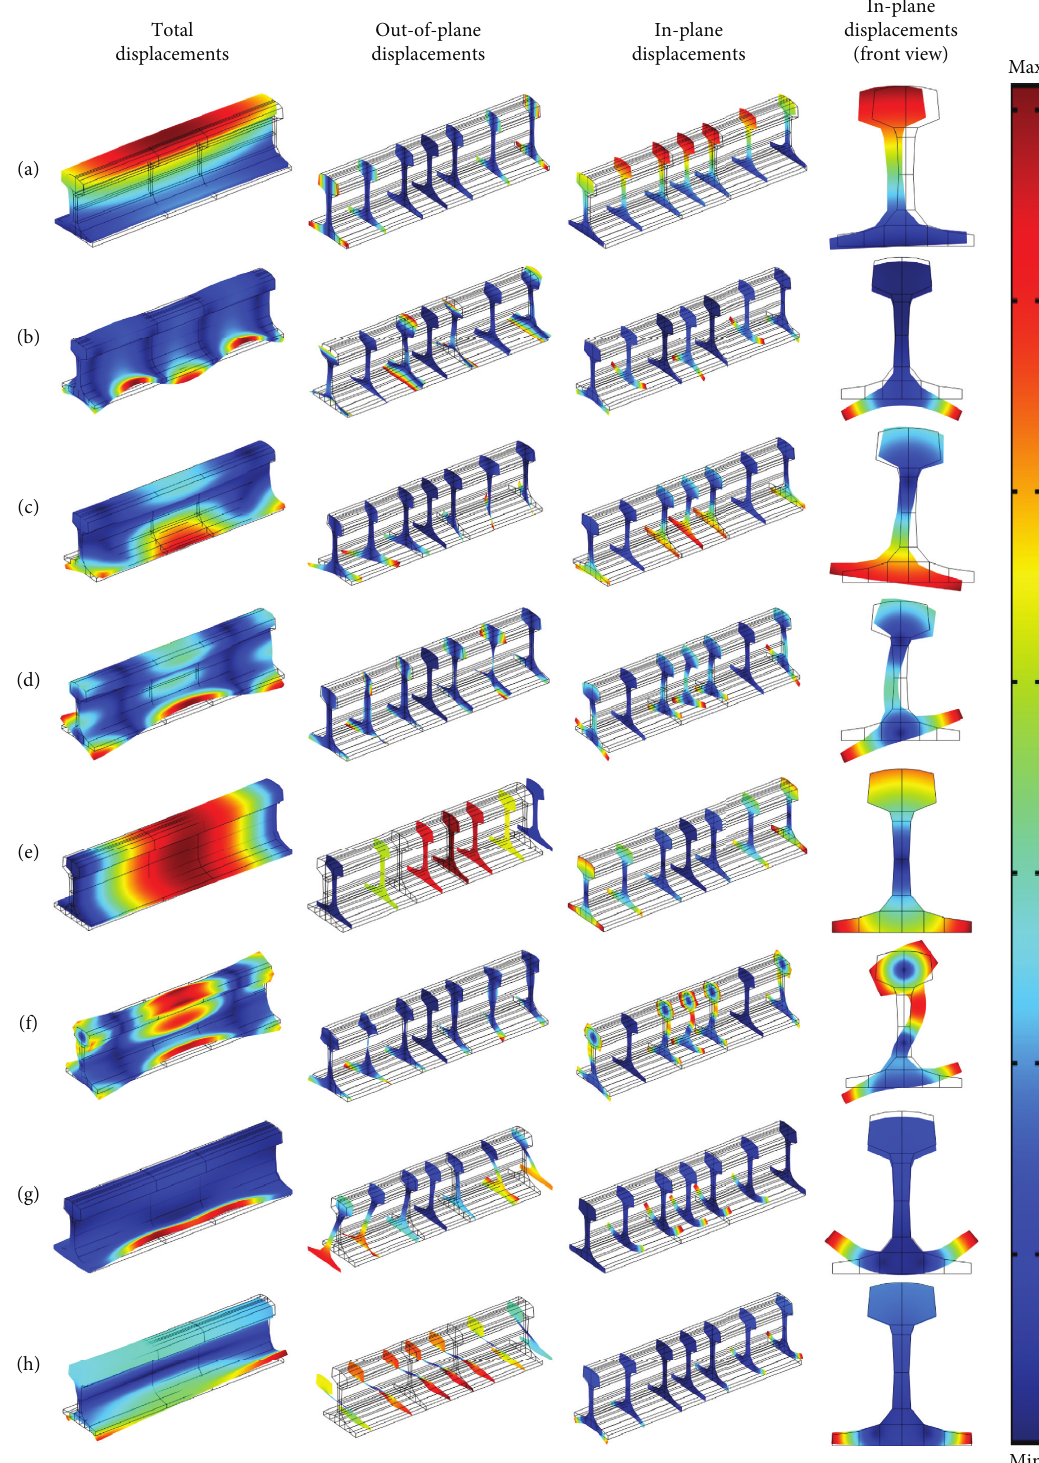
Figure 6: Wave modes corresponding to the marked points (a) ∼